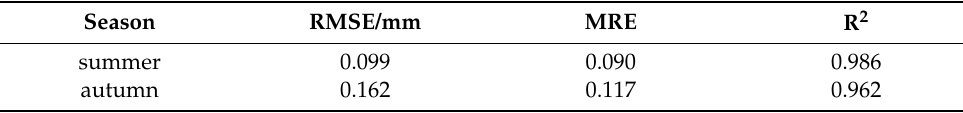
Table 3. Evaluation of inversion accuracy.